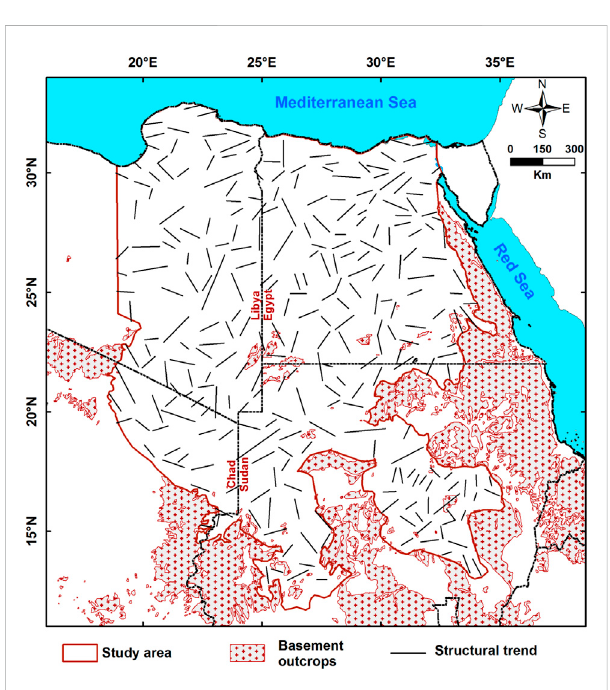
FIGURE 10 Gravity structural trends delineated from the high-pass fi ltered gravity map.